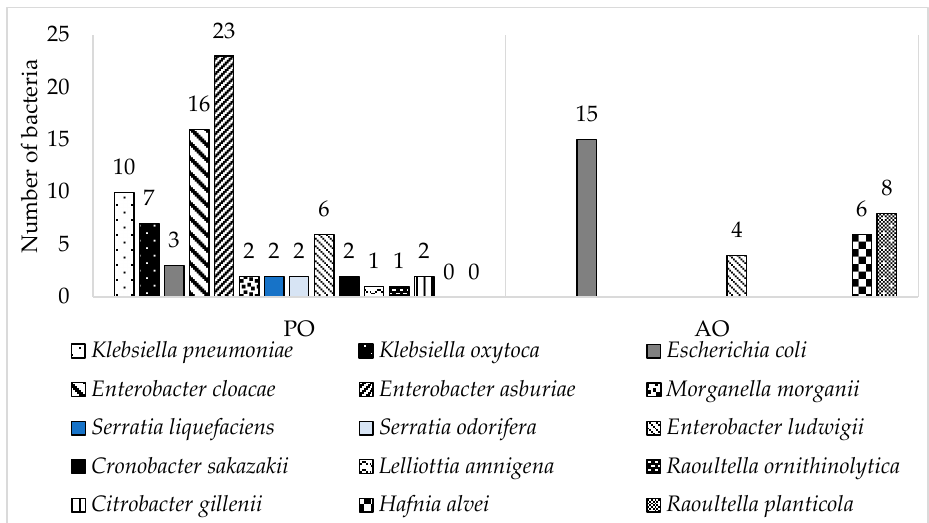
Figure 1. Number of identified resistant coliform bacteria isolated from samples of smoothie drinks (PO) and raw milk (AO).